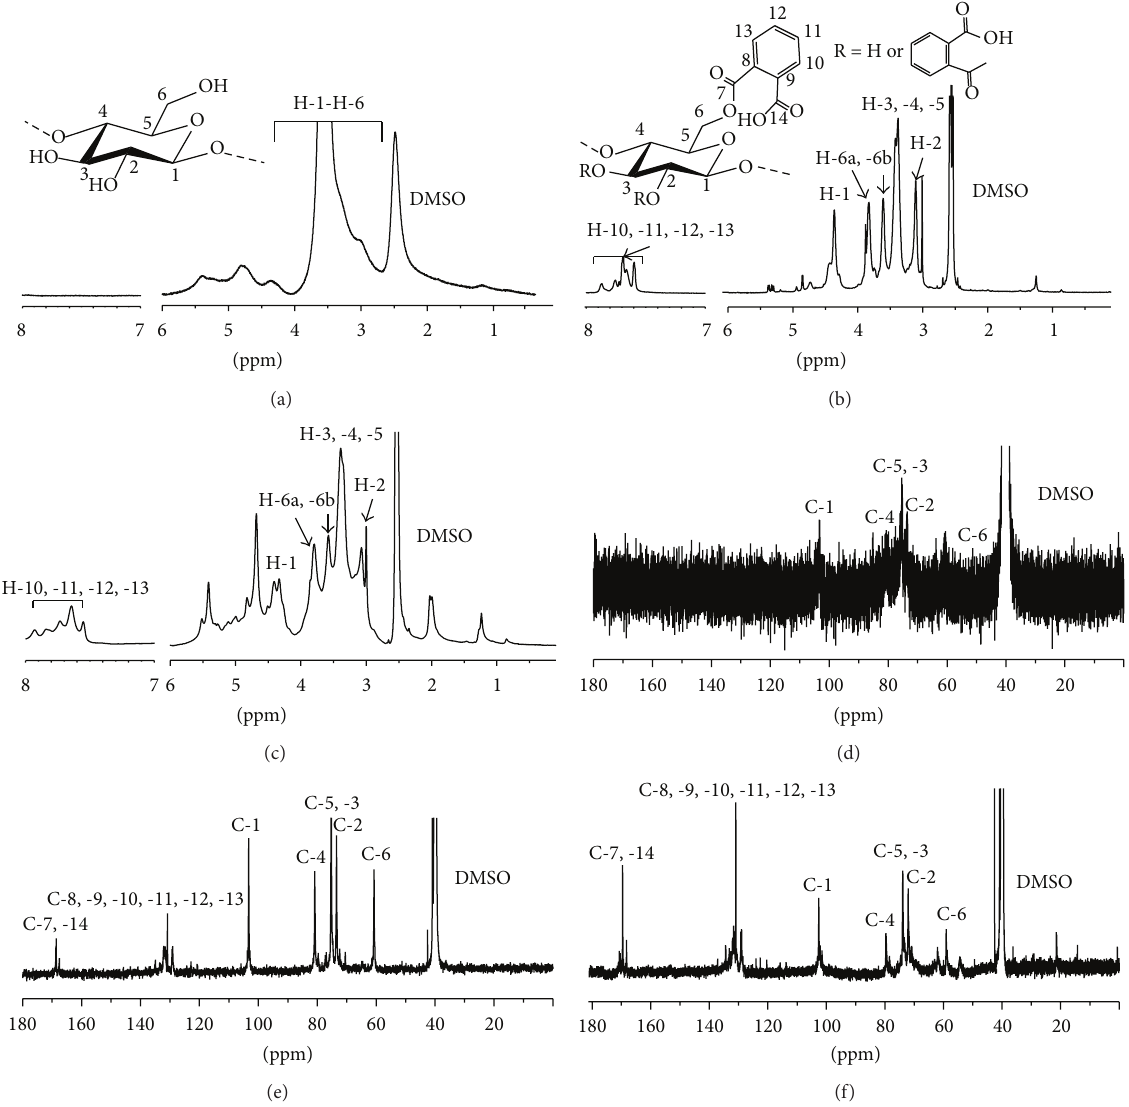
Figure 3: The 1 H ((a), (b), and (c)) and 13 C ((d), (e), and (f)) NMR spectra of unmodified cellulose (C0), phthalated cellulose (C5), and phthalated bagasse